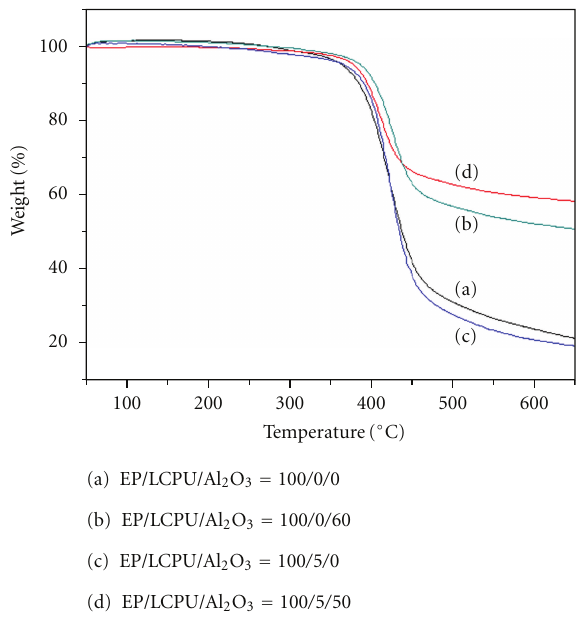
Figure 1: The TGA curves of